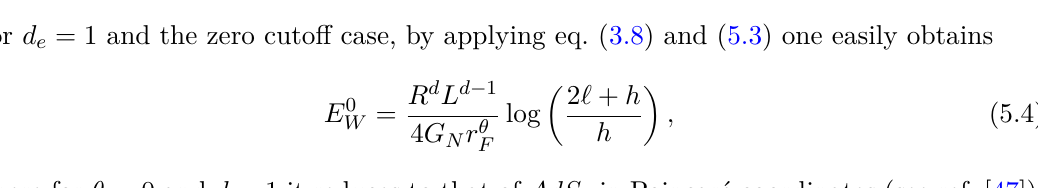
= 1 . The blue dashed curves are half of the HMI and the c as ˜ E = E W , where a = R d L d − 1 W W a 2 G N r θ F